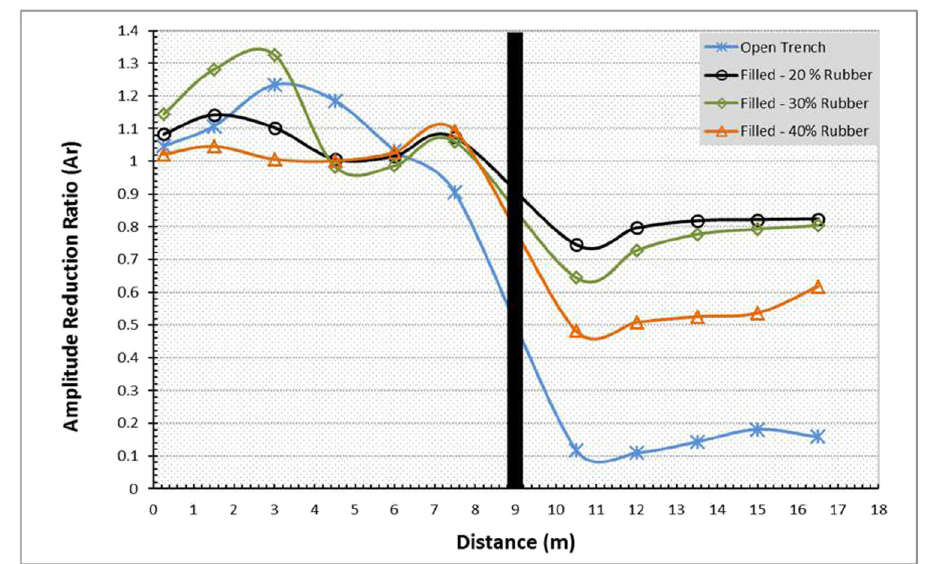
Figure 21: Attenuation of vibration due to passive trench barriers ( f 70 Hz = ) .